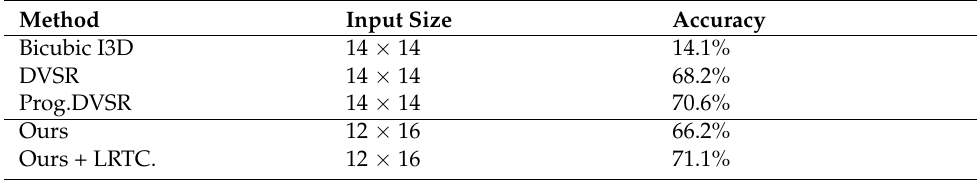
Table 5. The performance of the proposed method and other state-of-the-art methods on the UCF101 dataset. LRTC denotes long-range temporal